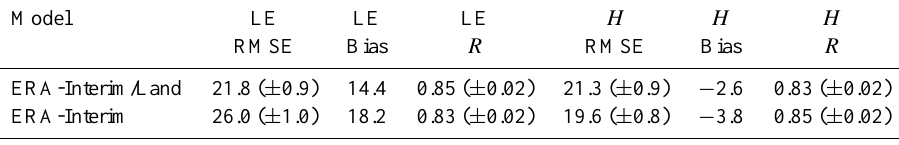
Table 3. Summary of mean latent heat flux (LE) and sensible heat flux ( H ) statistics averaged over the 34 sites (units: Wm − 2 ). The CI of RMSE is based on the Chi-squared distribution. The R of model fluxes to observations include a 95%CI calculated using a Fisher Z transform.